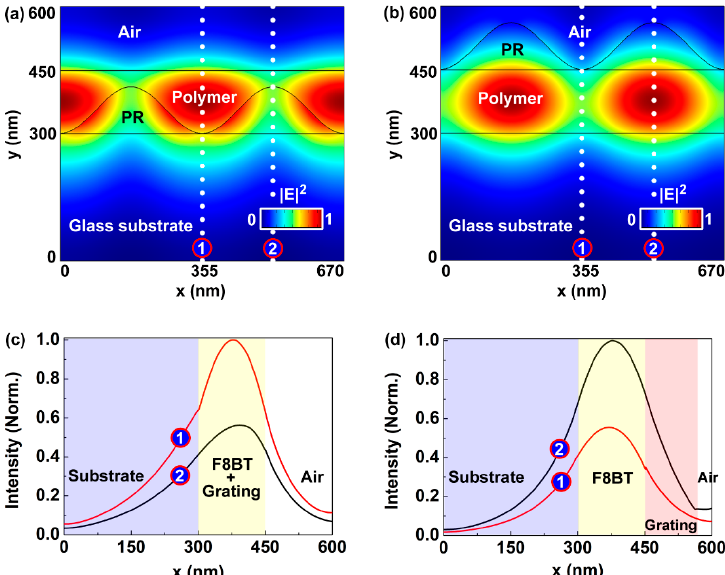
Figure 5. Electric field distribution of the 572 nm mode of ( a ) the SGA cavity and ( b ) the SAG cavity. Figures ( c ) and ( d ) are cross sections of the electrical field distribution of the mode extracted from ( a ) and ( b ) along the dotted white lines,